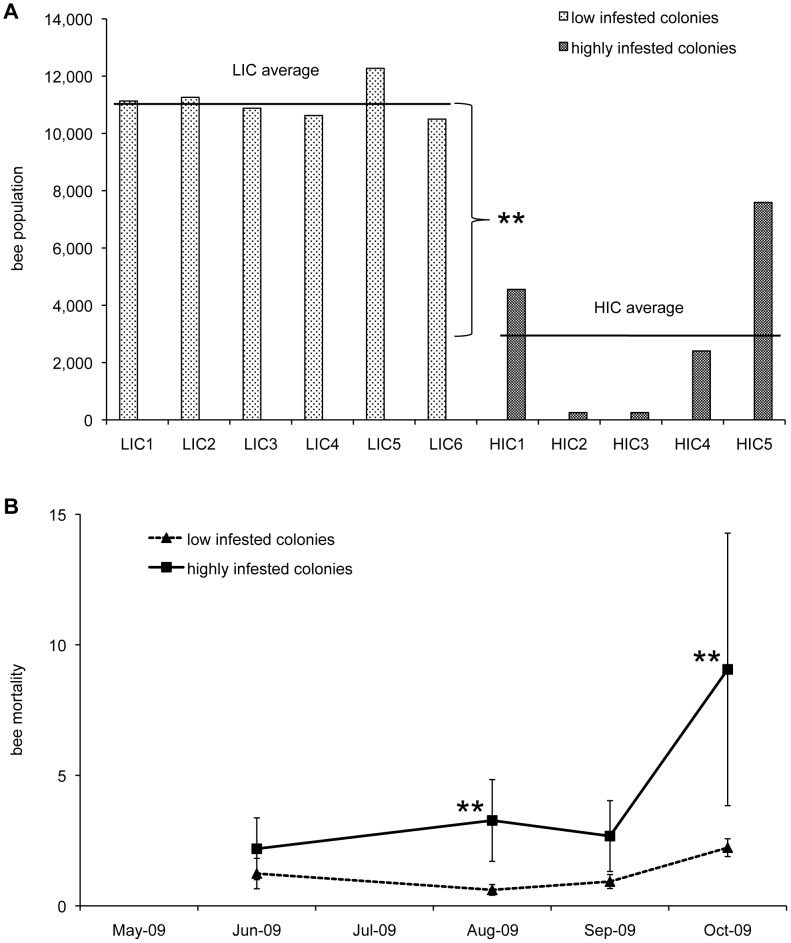
Seasonal dynamics of bees in colonies with low and high levels of mite infestation.(A) Estimated bee numbers recorded in each hive in October, when a sudden decrease of bee population was observed in highly infested colonies. (B) Bee mortality over time. The error bars indicate the standard deviation; mean values significantly different are denoted with asterisks (*P≤0.05; **P≤0.01). Bee population in highly infested colonies reached minimum levels in October, because of a marked increase of bee mortality.